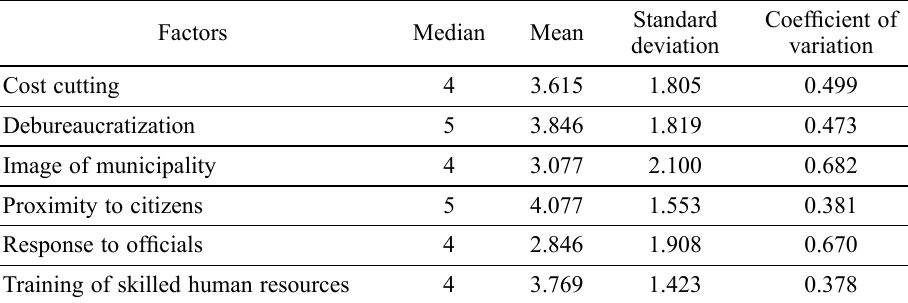
Table 7. Important factors for the promotion of technological change